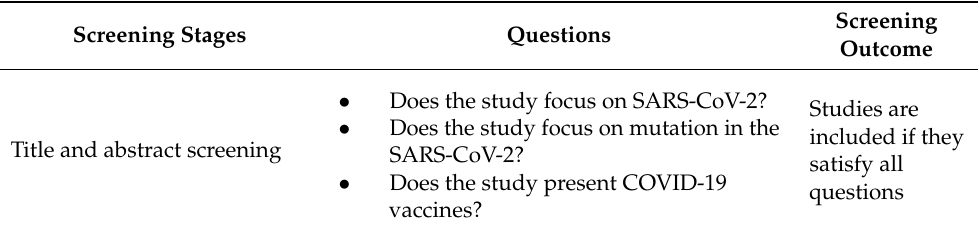
Table 1. List of questions used for studies inclusion and exclusion during combined title and abstract, and full-text